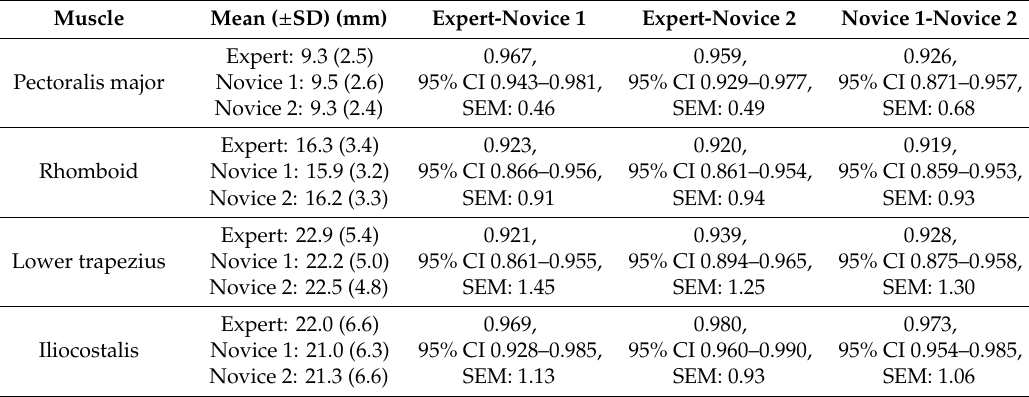
Table 2. Inter-rater reliability (ICC 3,k , 95% CI, SEM) of thickness measurements based on US acquisitions on di ff erent muscles of three